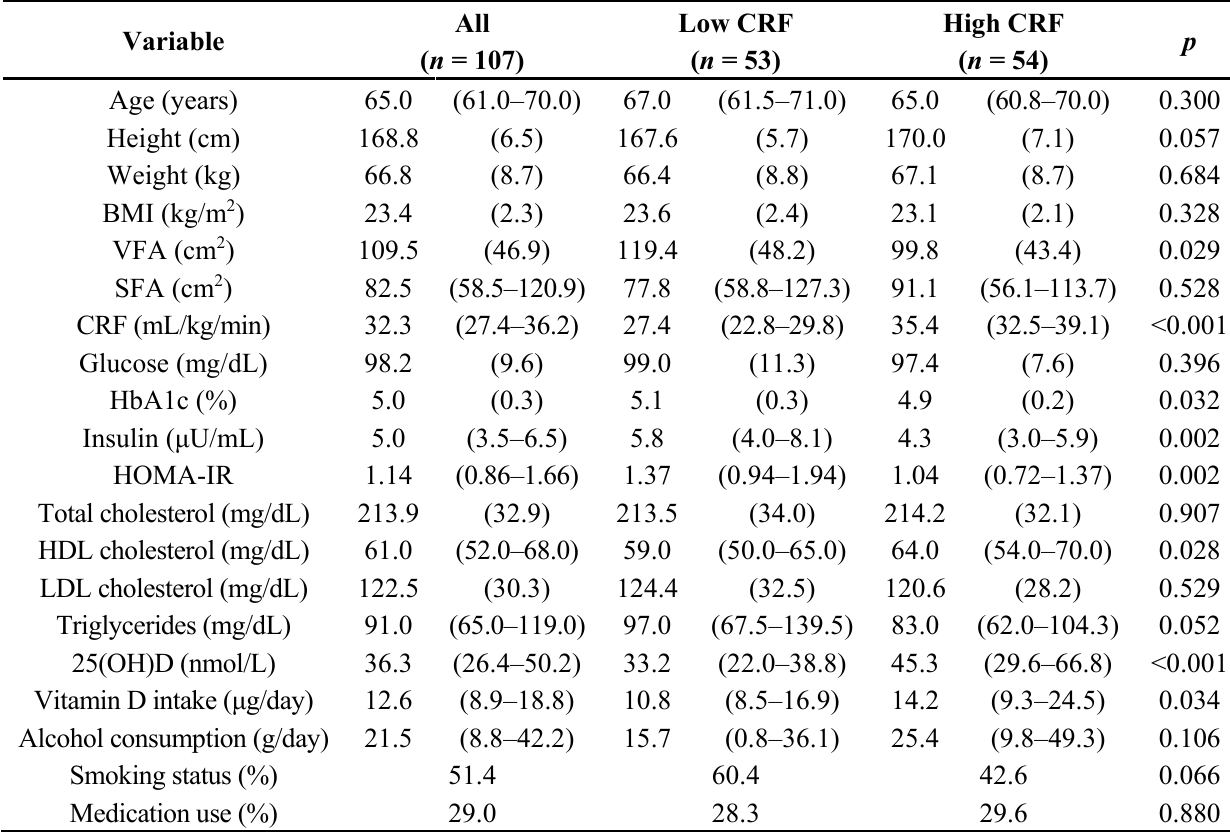
Table 1. Subject